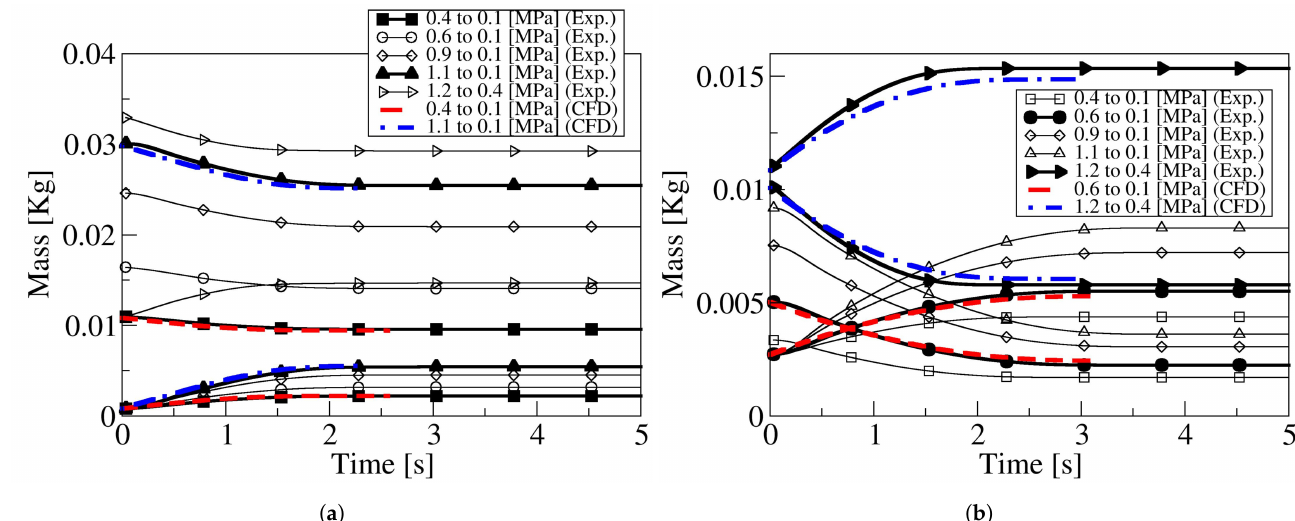
Figure 7. Temporal mass variation in each reservoir based on experimental data and for all pressures studied. ( a ) Flow from large to small reservoir. ( b ) Flow from small to large reservoir.